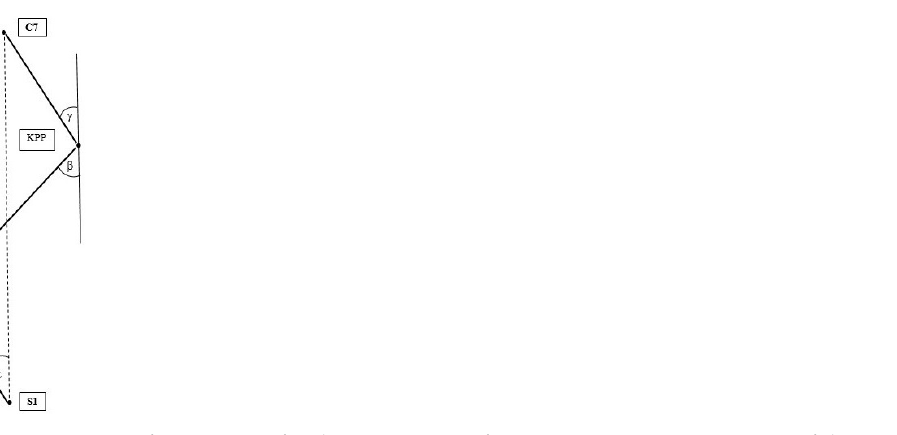
Figure 1. Summary of parameters for the assessment of anterior–posterior curvatures of the spine. Source: Own material.